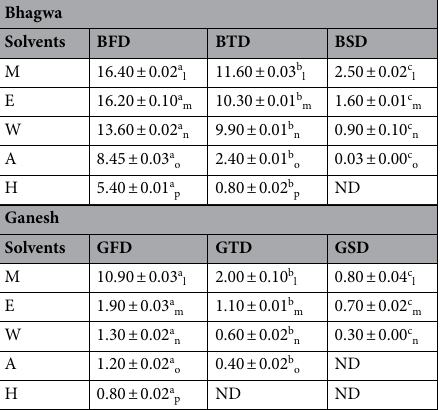
Table 4. Quantification of Gallic acid(mg/g) compounds from pomegranate peel extract. Mean ± SD n = 3, a, b, c represents a statistically significant difference between drying methods in row wise manner for specific solvent whereas l, m, n, o, p, q refers to statistically significant difference among solvents for respective drying method (column wise); BFD Bhagwa freeze dried, BTD Bhagwa tray-dried, BSD Bhagwa sun-dried,